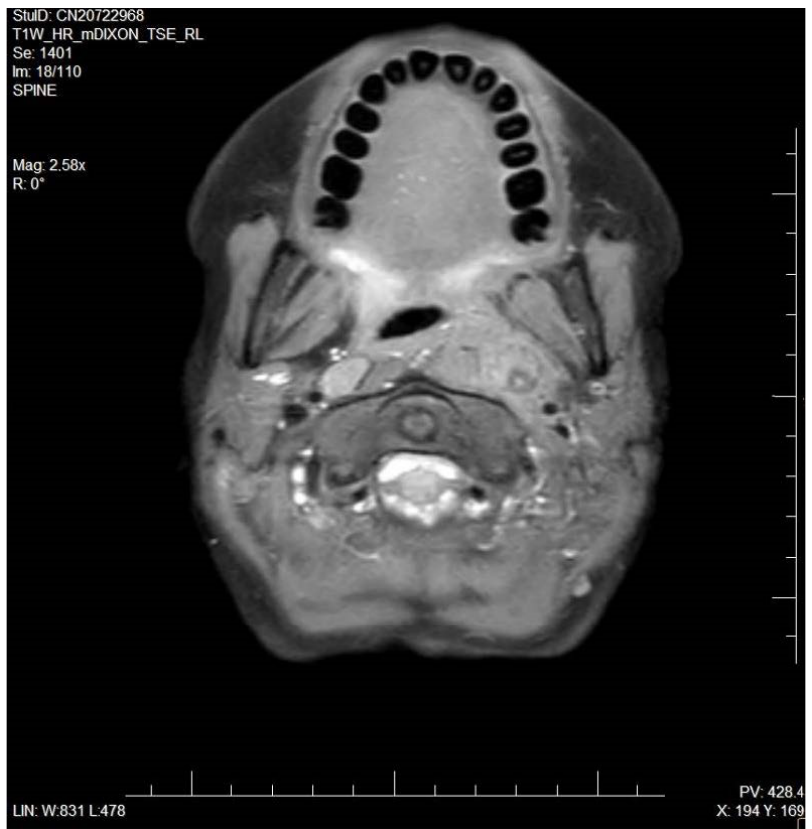
Figure 1. Magnetic resonance of head-transverse plane.